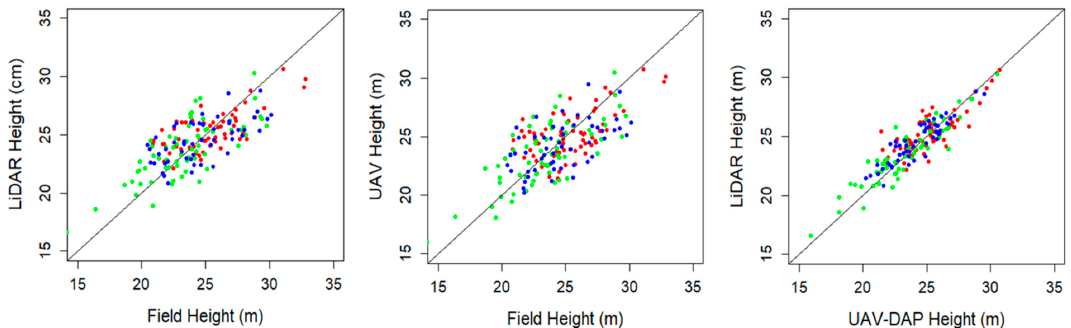
Figure 3. Correlation between tree heights derived from field survey, LiDAR, and UAV-DAP data. Red, green, and blue dots represent individual monarch birch, castor aralia, and Japanese oak tree heights, respectively.